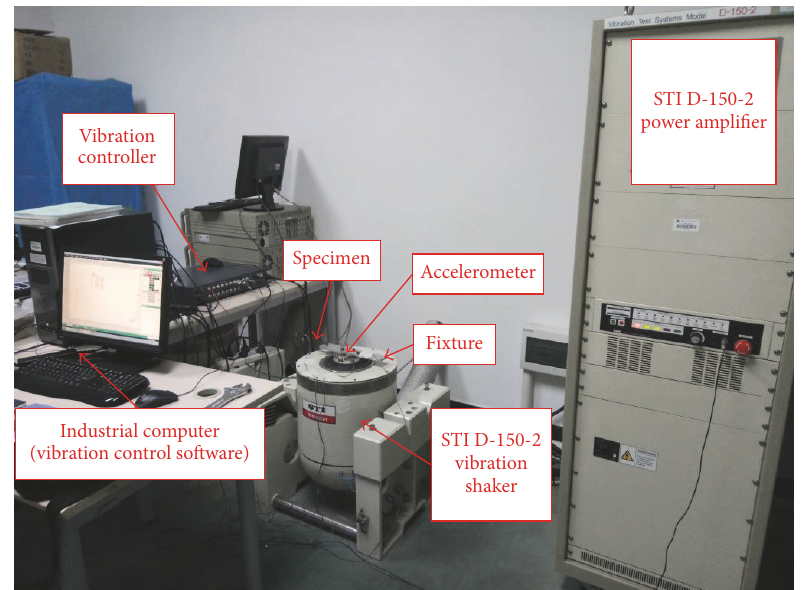
Figure 4: The actual vibration fatigue test